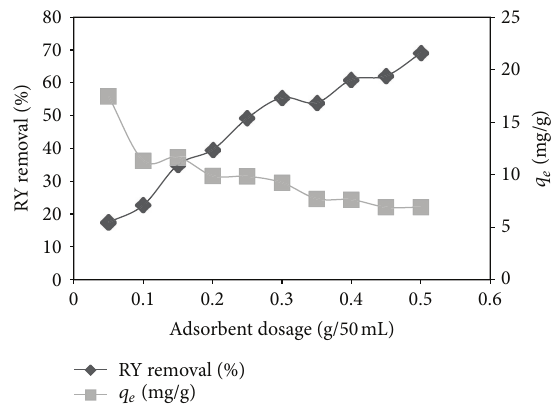
Figure 4: The adsorbent dosage effect for Remazol Yellow adsorp- tion (initial dye concentration: 100mg/L, contact time: 60 min, temperature: 293 K, pH: 2).